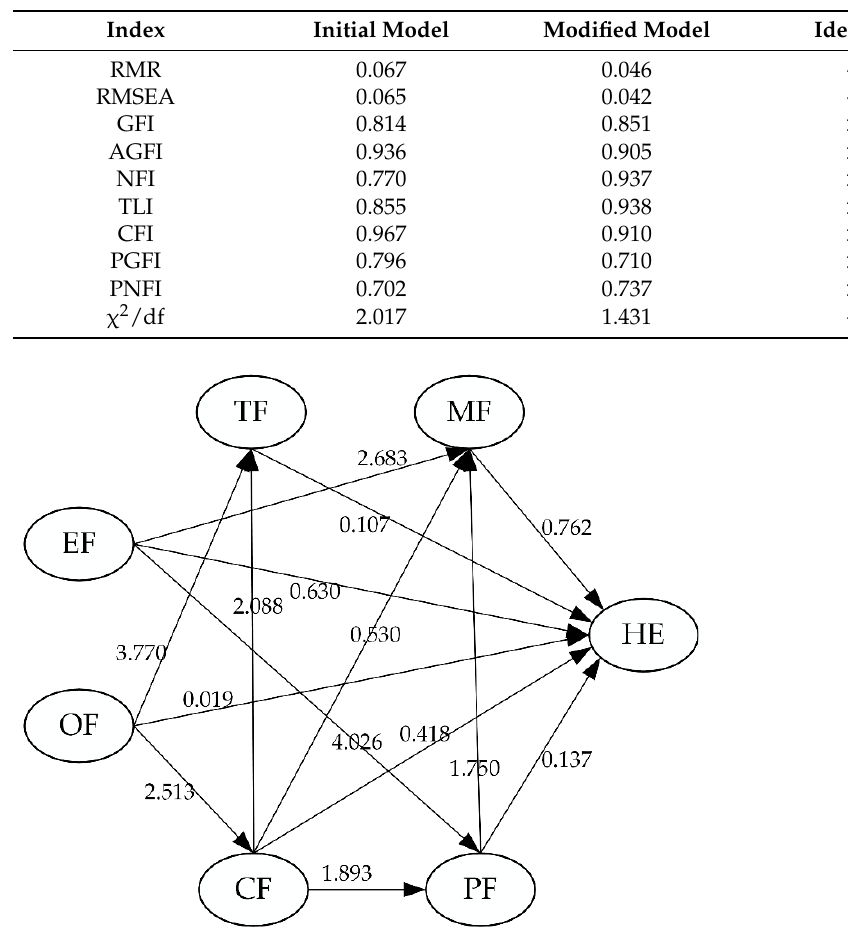
Figure 2. C.R. value between the latent variables. Table 6. The adaptation degree results of the optimal model.